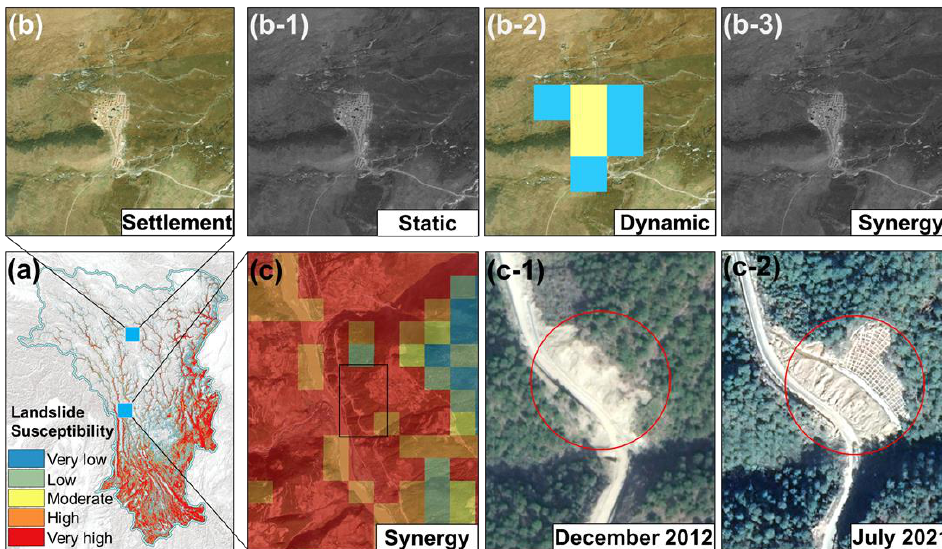
Figure 13. The LS of the central transverse mountain area. ( a ) is the LS map of the Hengduan Mountains region. ( b ) shows different LS assessment results in static feature mode ( b-1 ), dynamic feature mode ( b-2 ), and synergy feature mode ( b-3 ). ( c ) displays details of a site prone to landslide using Ersi and Google satellite image; ( c-1 ) shows early sign of landslide and ( c-2 ) shows an recently constructed artificial slope protection building. Results show that using the dynamic feature mode can identify spatial texture structure information, and, when combined with static feature mode, it can reduce the false alarm rate and ensure the reliability of results.